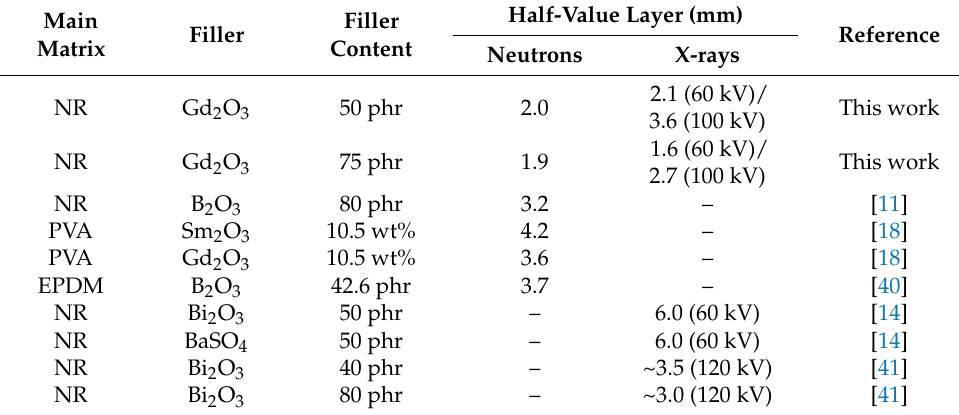
Table 3. Comparison of neutron- and X-ray-shielding properties based on the half-value layer (HVL) between the results from this work and those from similar materials. Numbers in parentheses represent supplied voltages used for X-ray-shielding